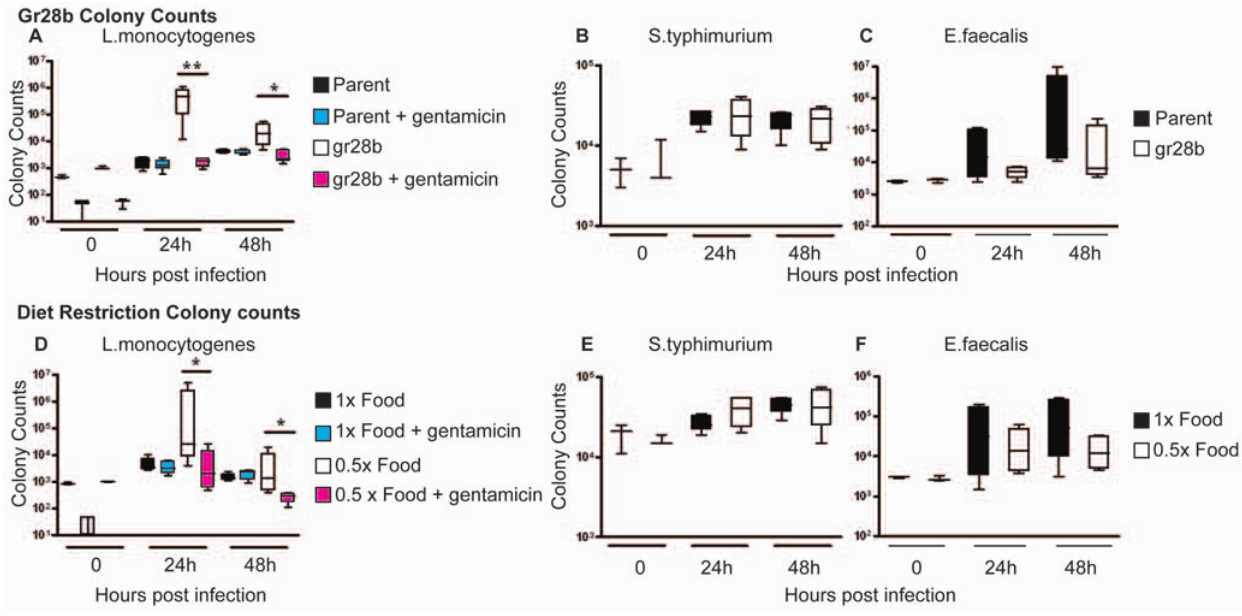
Figure 4. Effect of gr28b mutation and diet restriction on the growth of L.monocytogenes and S.typhimurium . Isogenic wild-type and gr28b homozygous mutant flies or wild-type flies fed on 1 6 and 0.5 6 diets were challenged with pathogens. Because L. monocytogenes infections showed a change in pathogen levels, half of the infected flies were injected with gentamicin to determine the relative abundance of intracellular and extracellular bacteria. Wild-type versus gr28b mutants: (A) L. monocytogenes ; (B) S. typhimurium ; and (C) E. faecalis . Regular food versus diet restriction: (D) L. monocytogenes ; (E) S. typhimurium ; (F) E. faecalis . Error bars indicate standard deviation. Statistical analysis was done using an unpaired two- tailed t -test. One asterisk indicates p , 0.01 and two asterisks indicates p , 0.005.